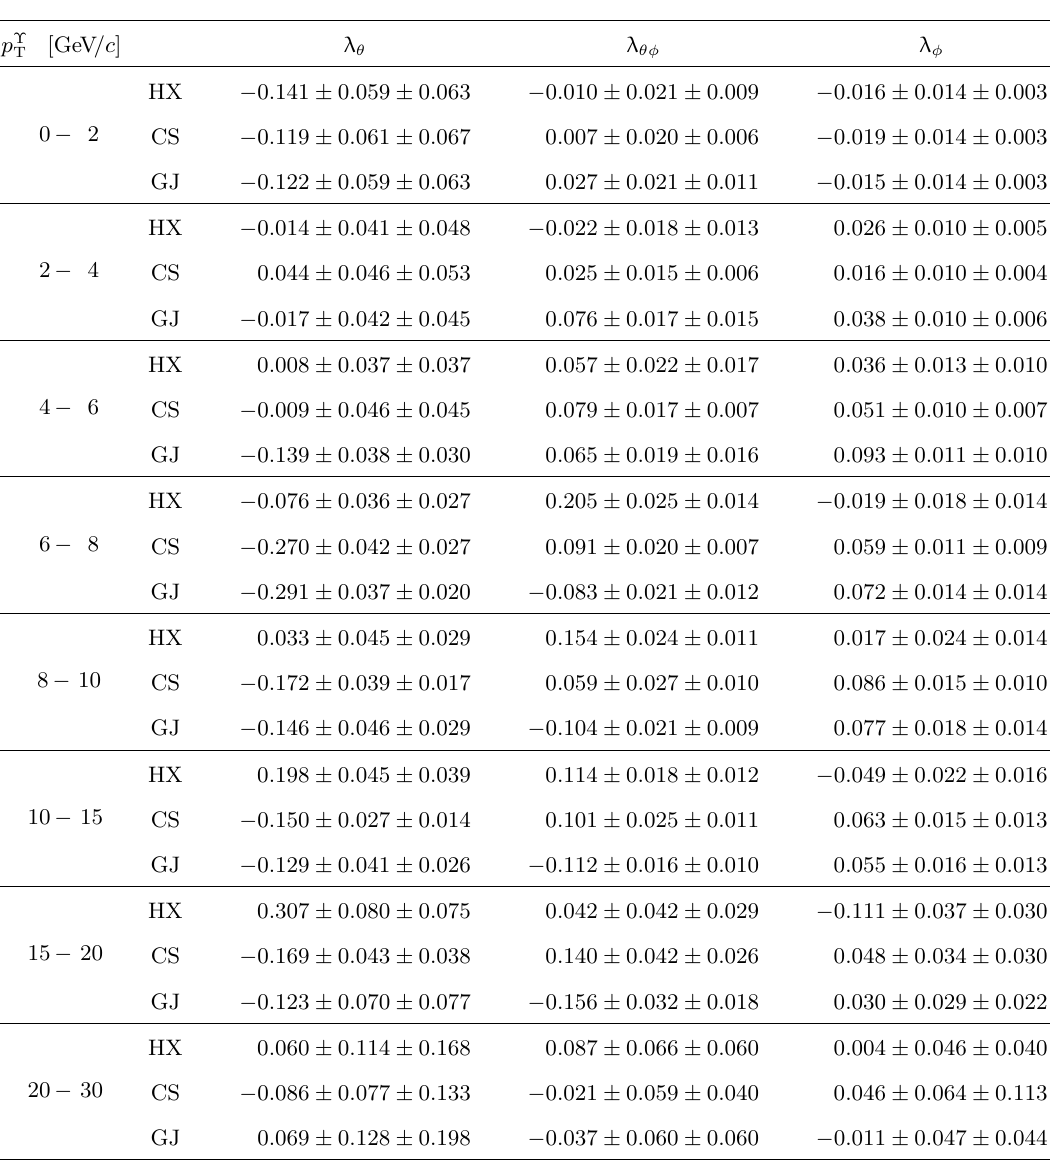
Table 27 . Values of (cid:21) (cid:18) , (cid:21) (cid:18)(cid:30) and (cid:21) (cid:30) measured in the HX, CS and GJ frames for the (cid:7)(3S) produced p at s = 8 TeV in the rapidity range 2 : 2 < y (cid:7) < 4 : 5. The (cid:12)rst uncertainty is statistical and the second